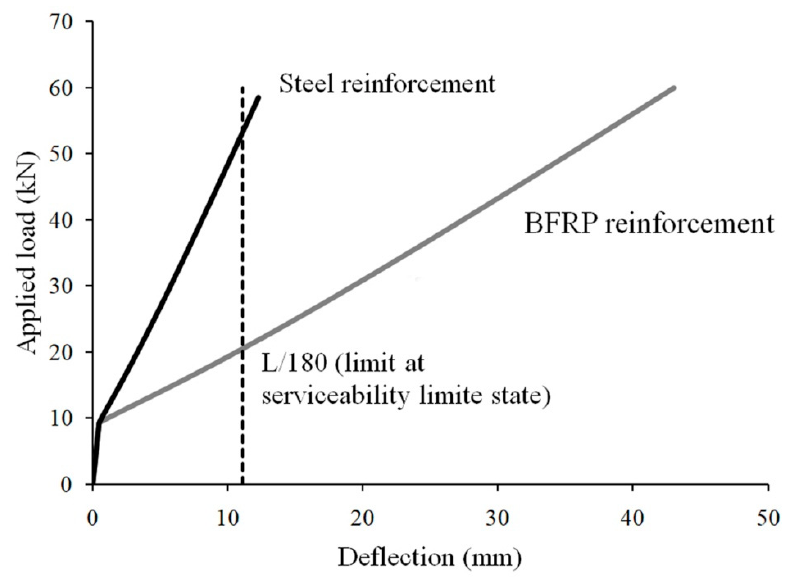
Figure 5. Simulation, based on [24] of the load-deflection response of a beam with tensile flexural reinforcement in mild steel (black line) and BFRP (grey line).